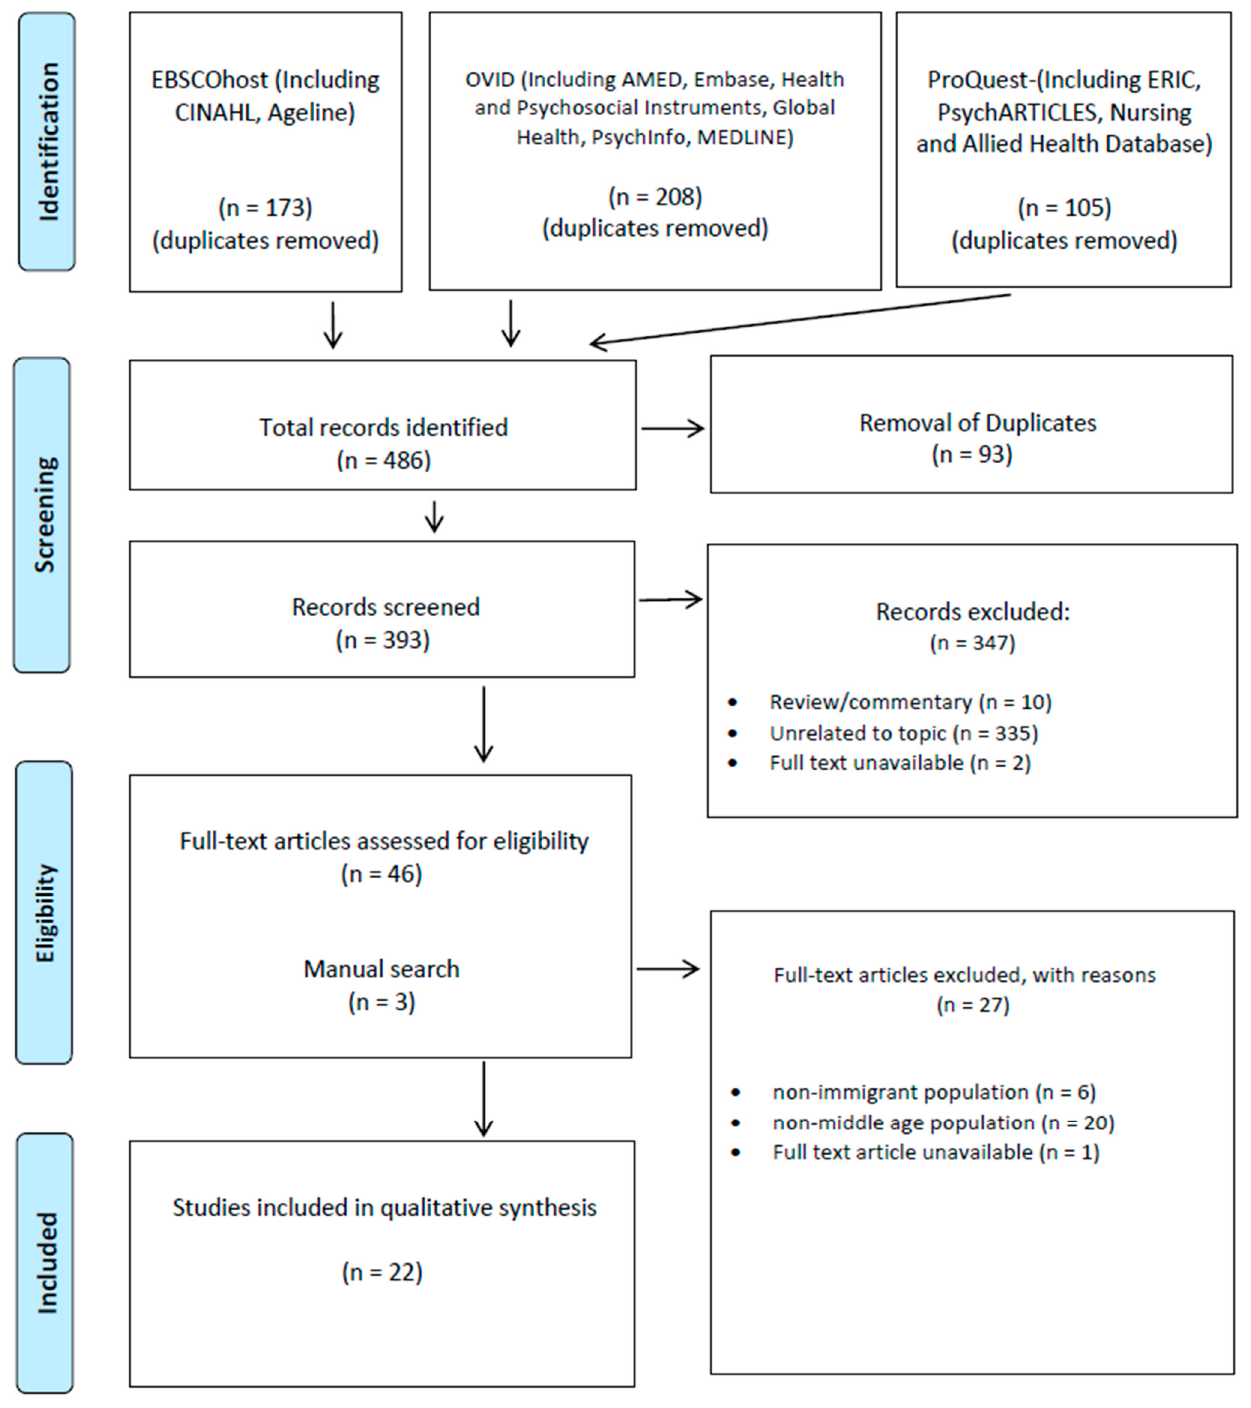
Figure 1. Searching process.